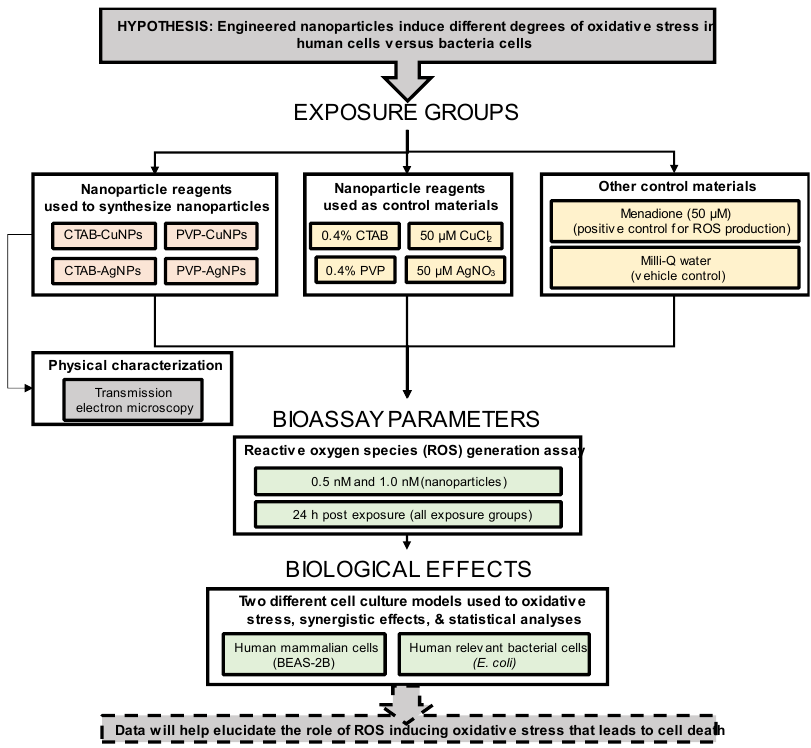
Figure 1. Experimental design showing exposure variables to determine induced reactive-oxygen- species (ROS) generation in bacteria and mammalian cells after nanoparticle exposure. species (ROS) generation in bacteria and mammalian cells after nanoparticle